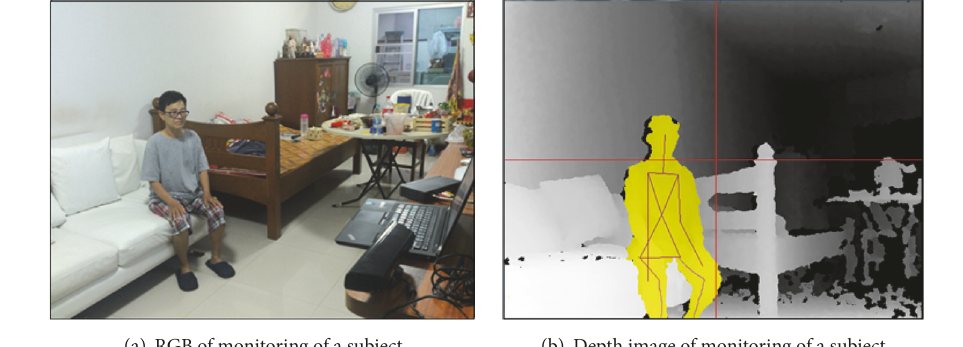
Figure 2: Setting for proposed system within a